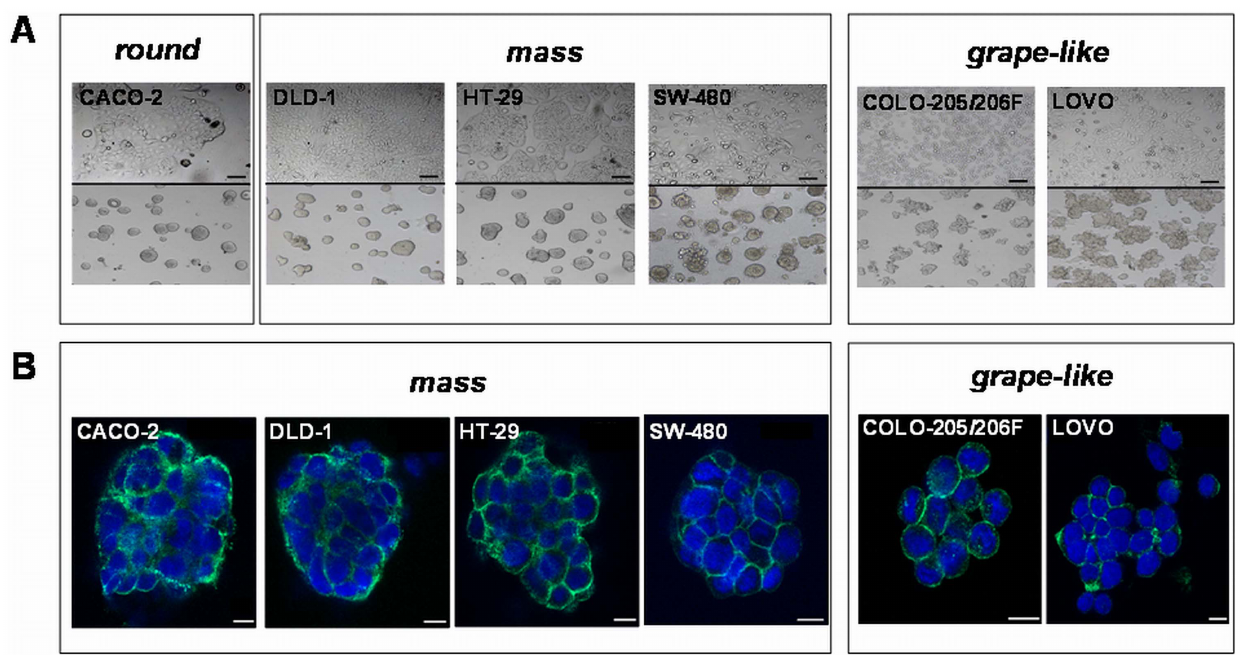
Figure 1. Morphology of 2D and lrECM 3D cultivated CRC cells. A) Growth morphology of CRC cell lines cultivated under 2D (upper panel) and lrECM 3D on-top assay conditions (lower panel). Cells cultivated in 3D condition either show a round (CACO-2), mass (DLD-1, HT-29, SW-480) or a grape-like morphology (COLO 205, COLO-206F, LOVO) in phase contrast images. Scale bars: 100 m m. B) Confocal laser scanning fluorescence microscopy images of CRC spheroids. Spheroids were grown in lrECM 3D microenvironments for seven days. Subsequent to isolation, the membranous EpCAM protein (green) was stained using Alexa Fluor H 488 goat anti-mouse IgG. Nuclei were counterstained with DAPI (blue). Scale bars 10 m m.